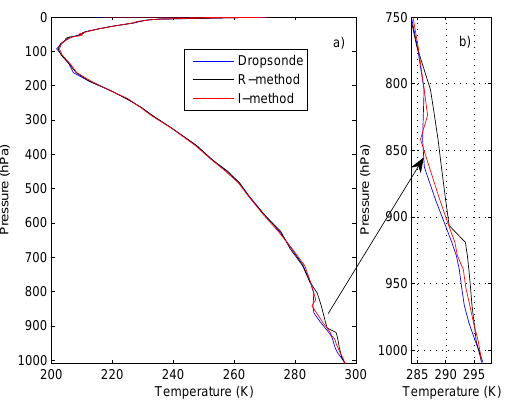
Figure 13. Results for the JAIVEx case study and for ( N = 300 , x April 2007. The figure shows the mean retrieved profile for temperature for the two retrieval approaches and their comparison with the dropsonde observation. The retrieved profile has been averaged over the 16 available IASI